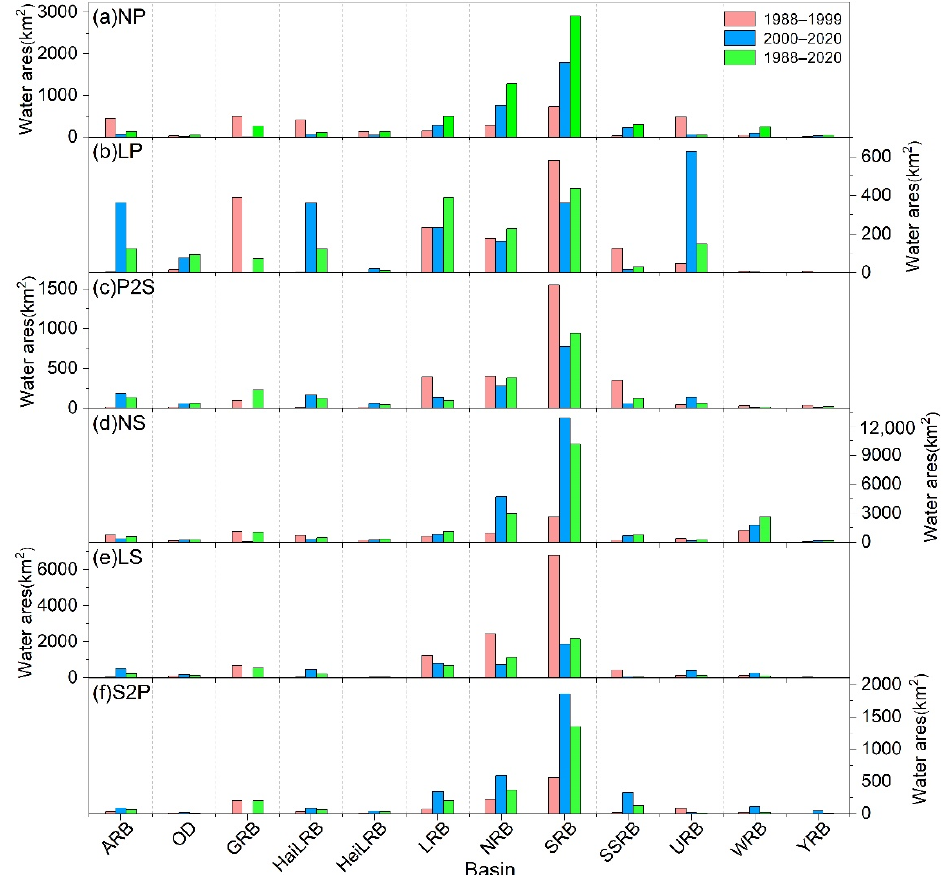
Figure 6. Conversion of surface water bodies in the basins: ( a – f ) are the areas of NP, LP, P2S, NS, LS, and S2P in the three-time periods of 1988–1999, 2000–2020, and 1988–2020 in each basin. The spatial distribution of water bodies’ conversion from 1988 to 2020 is shown in Figure 7. Unchanged permanent water bodies and seasonal water bodies are 17,044.832 km